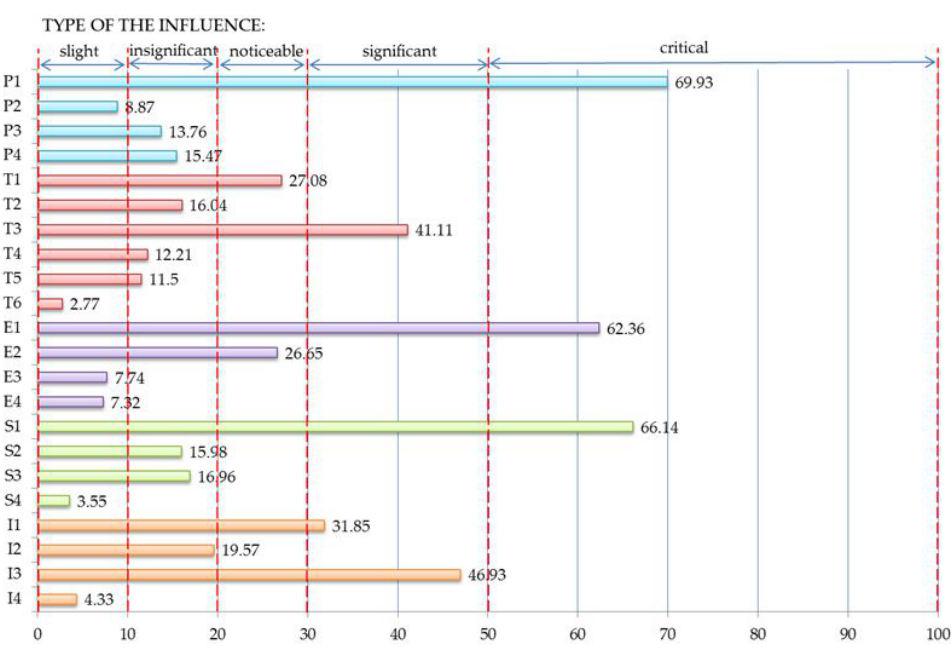
Figure 7. Categorization of the impact of the power market introduction on the energy sector.